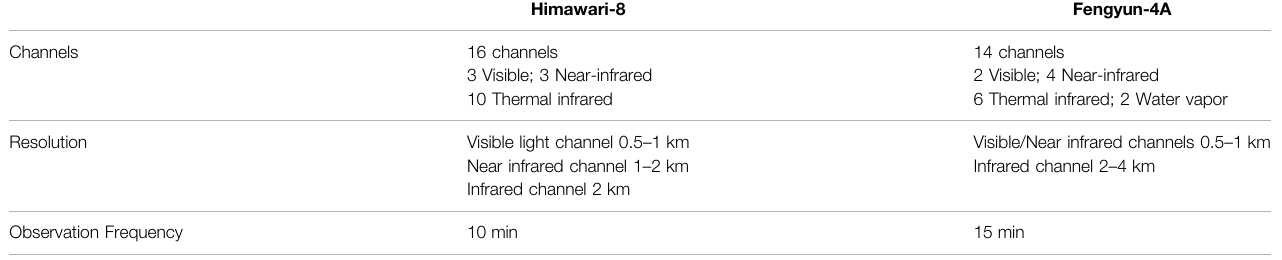
TABLE 1 | Satellite data comparison.